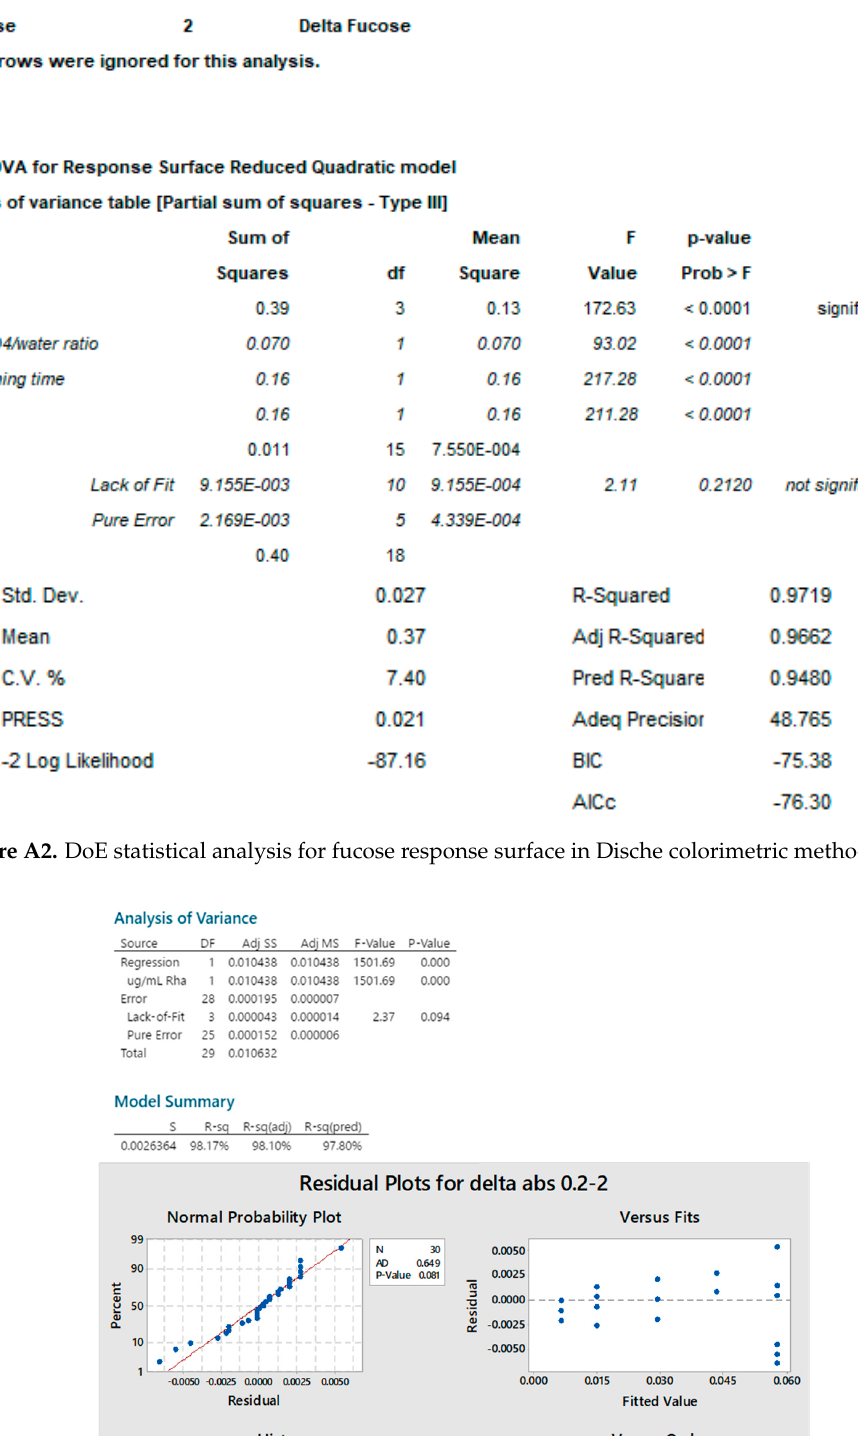
Figure A1. DoE statistical analysis for glucose response surface in Dische colorimetric method.